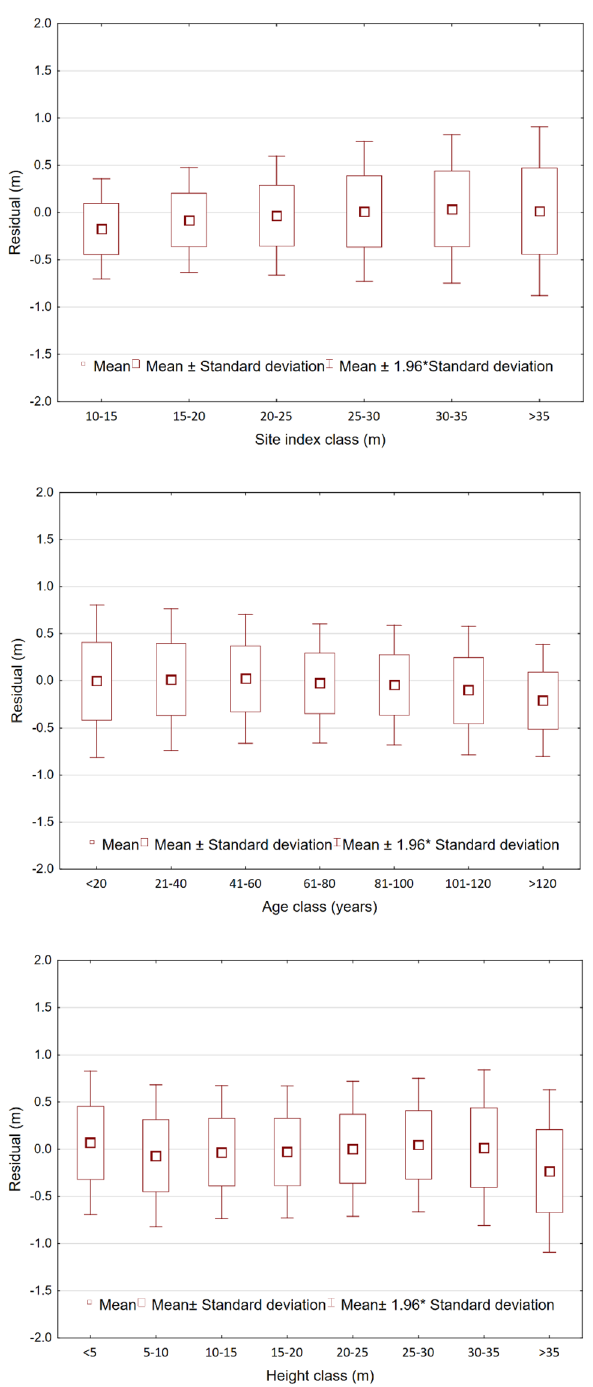
Figure 3. Mean values of the residuals of the regional nonlinear fixed-effect model in site index, age and height